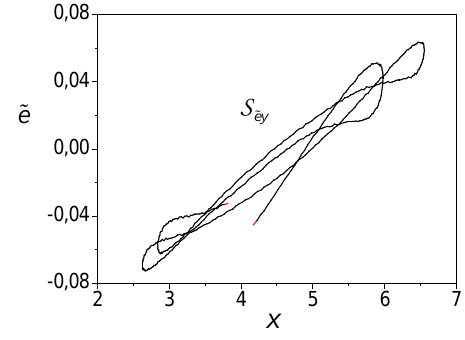
Fig. 2. System phase portrait and hysteresis change.